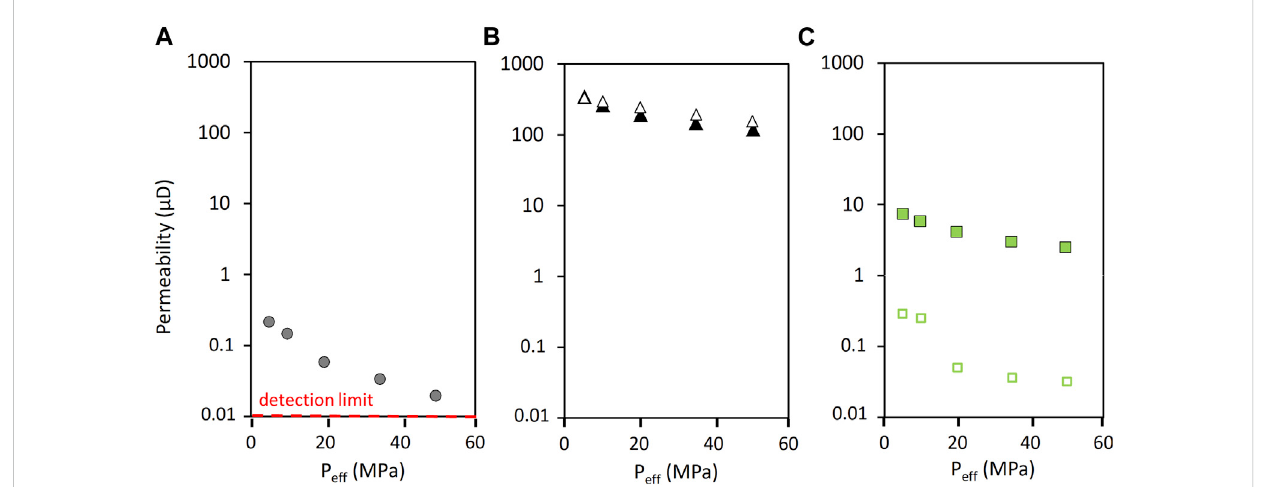
FIGURE 9 Permeability versusP eff fortheSWG (A) ,PTB (B) ,andMSA (C) lithologiesbeforeandafterthermalshocking.Smaller, emptysymbolsrepresent k data associatedwithpre-thermalshockingandlarger, fi lledsymbolsrepresent k dataassociatedwithpost-thermalshocking.PermeabilityfortheSWGsample beforethermalshockingwasbelowthedetectionlimitofthepermeameter(0.01 μ D),andthereforeisnotplotted.Errorbarsarelessthan1%ofmeasured